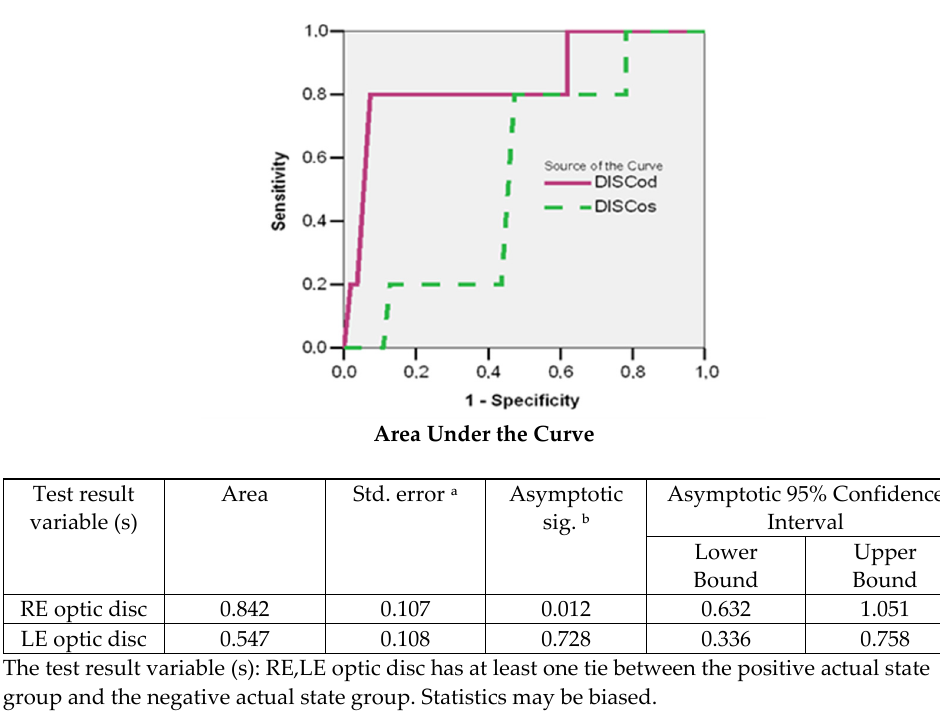
Figure 3. Comparative values of the optic disc compared to the eyes according to the type of sleep apnea syndrome. * and circle maxim/minim mean level of the type of disease. By tracing the ROC curve, it is highlighted that, in the right eye, the optical disc area is a good predictor in determining severe SAS (AUC = 0.842; IC95: 0.632–1.051; p = 0.012) (Figure 4).